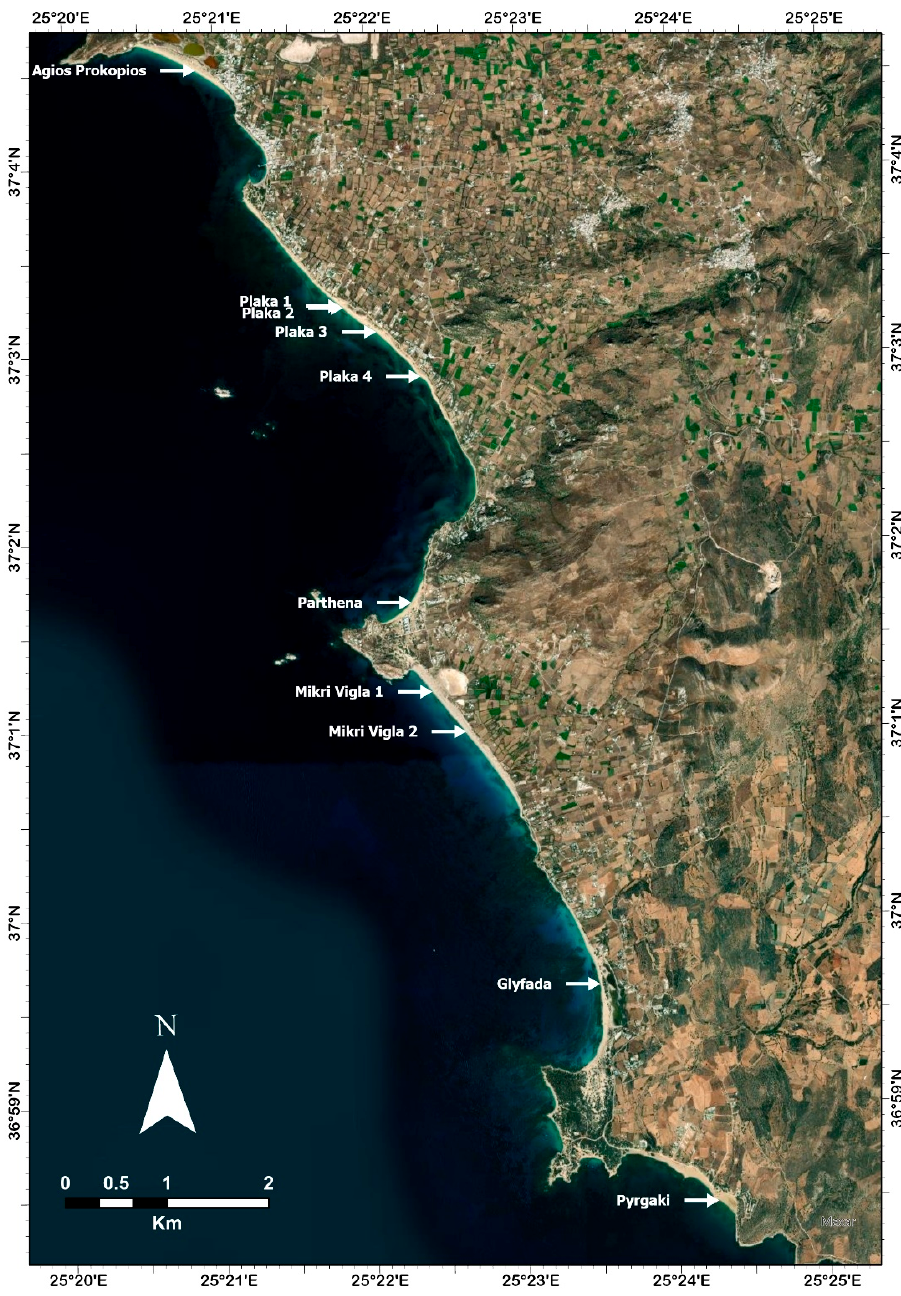
Figure 3. Locations of the investigated dunes fields and the cross sections.